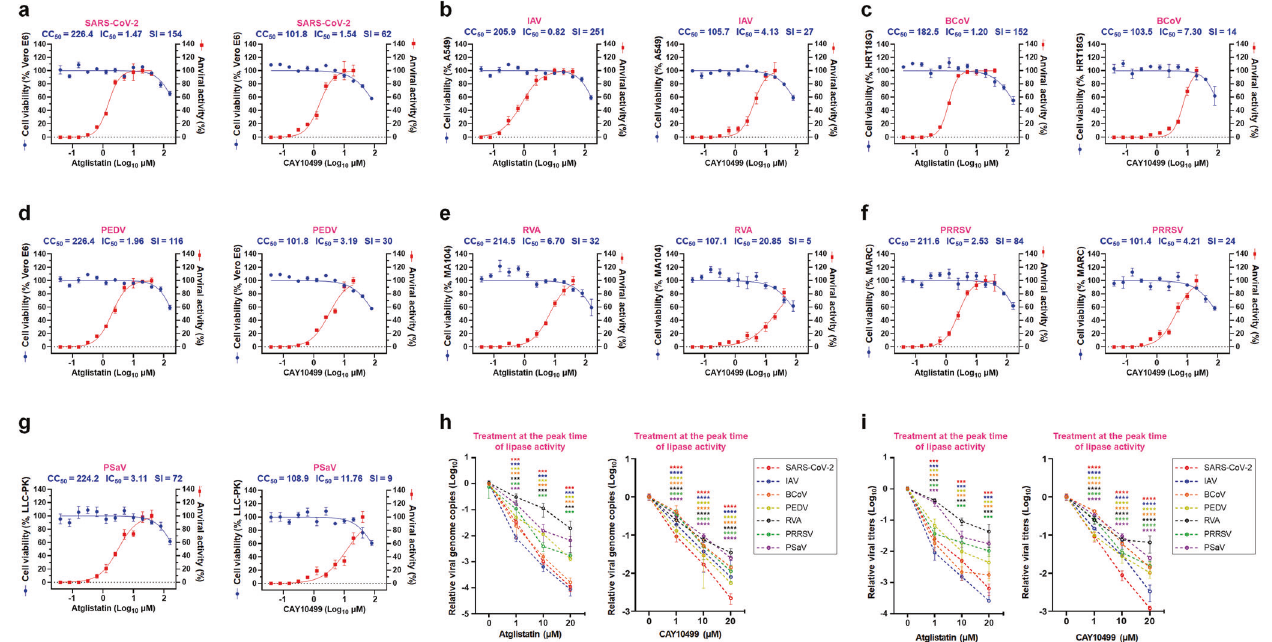
Fig. 4 In vitro broad-spectrum safety and antiviral effect of lipase inhibitors. a – g Dose – response curves for half-maximal inhibitory concentration (IC 50 ) and half-maximal cytotoxicity concentration (CC 50 ) and selective index (SI) of atglistatin and CAY10499 against seven target RNA viruses. The viral yield in the cell supernatant was quanti fi ed by cell-culture immuno fl uorescence assay. Cytotoxicity of atglistatin and CAY10499 to each cell line was measured by MTT assay. h , i Effect of atglistatin and CAY10499 on reduction in viral genome copy numbers and viral infectivity titers for seven different RNA viruses in infected cells when treated just prior to the peak of lipase activity. Treatment times are shown in Supplementary Table 4. All data in the graphs are presented as arithmetic means ± SD from four independent experiments. One- way analysis of variance with Tukey ’ s correction for multiple